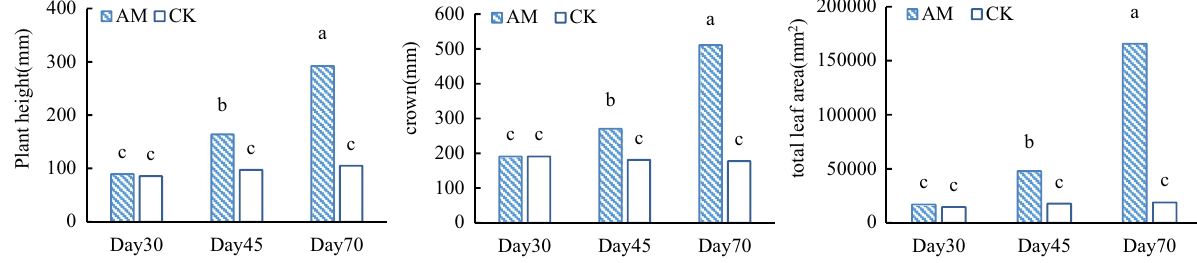
Figure 1. Effects of AMF inoculation on non-complex characteristics of the peanut canopy. Within each figure, columns without the same letter are significantly different by LSD ( p < 0.05); AM, mycorrhizal (inoculated with the AMF); CK, uninoculated control; n =